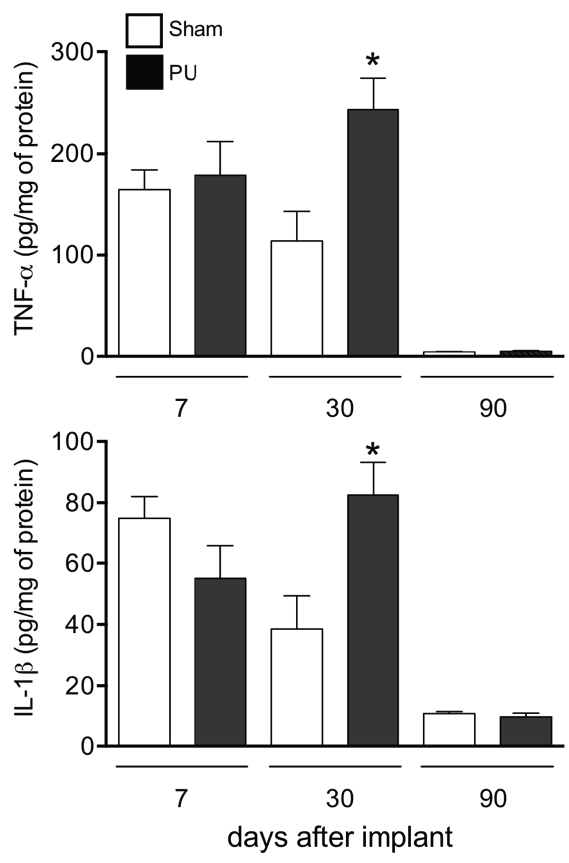
Figure 4 - Infl uence of PU on cytokine levels of the dorsal skin of rats at diff erent time intervals after the implant. Data are presented as mean ± S.E.M. (n=8 animals per group) in relation to the Sham group. One-way ANOVA followed by Tukey’s test; (*) p <